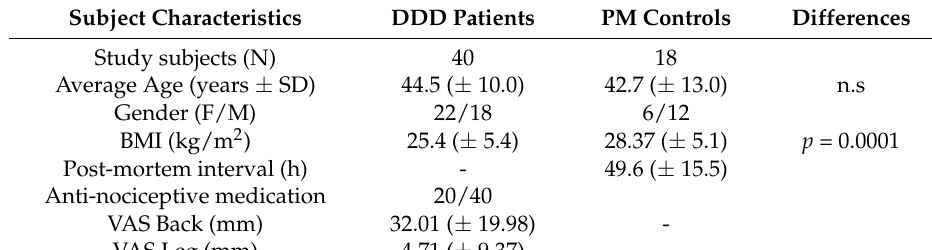
Table 1. Demographic and clinical characteristics of degenerative disc disease (DDD) patients and postmortem (PM) controls included in study. Data presented as mean ± Standard Deviation. (BMI=body mass index; Pain VAS = visual analogue scale; ODI = Oswestry Disability Index; n.s = non-significance; - = not applicable; qRT-PCR = quantitative real-time polymerase chain reaction; ELISA = enzyme-linked immunosorbent assay) Pain VAS = 0–100, worst = 100; ODI = 0–100, worst =